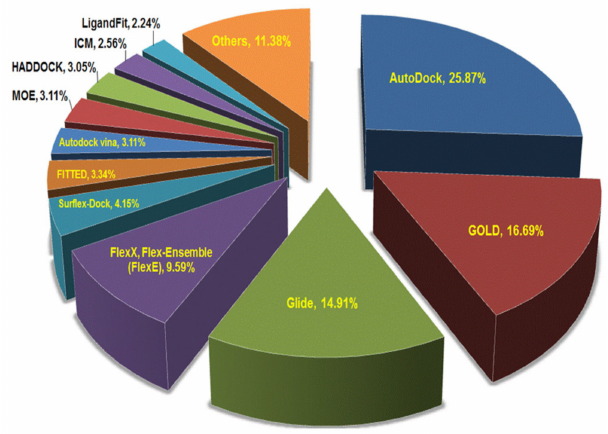
Figure 3. The rate of citation of di ff erent molecular docking programs, in which Autodock, GOLD and Glide are the most commonly used ones, modified through reference